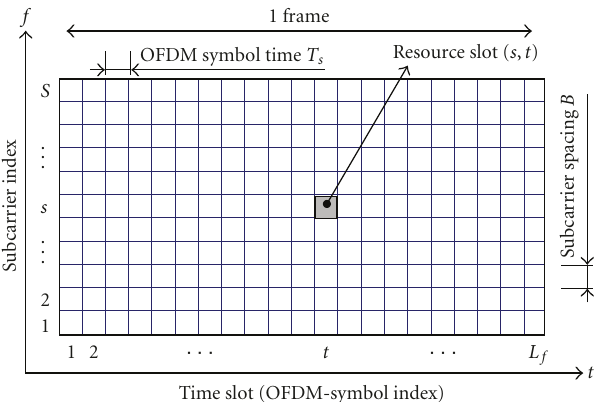
Figure 4: Frame structure and elementary resource